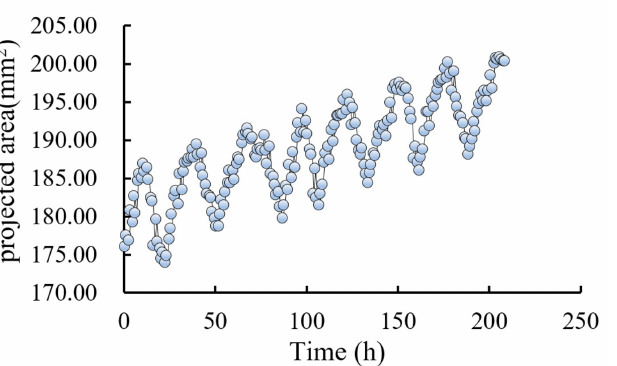
Figure 14. Changes of the projected area of the particles of Sunshine Muscat grapes over